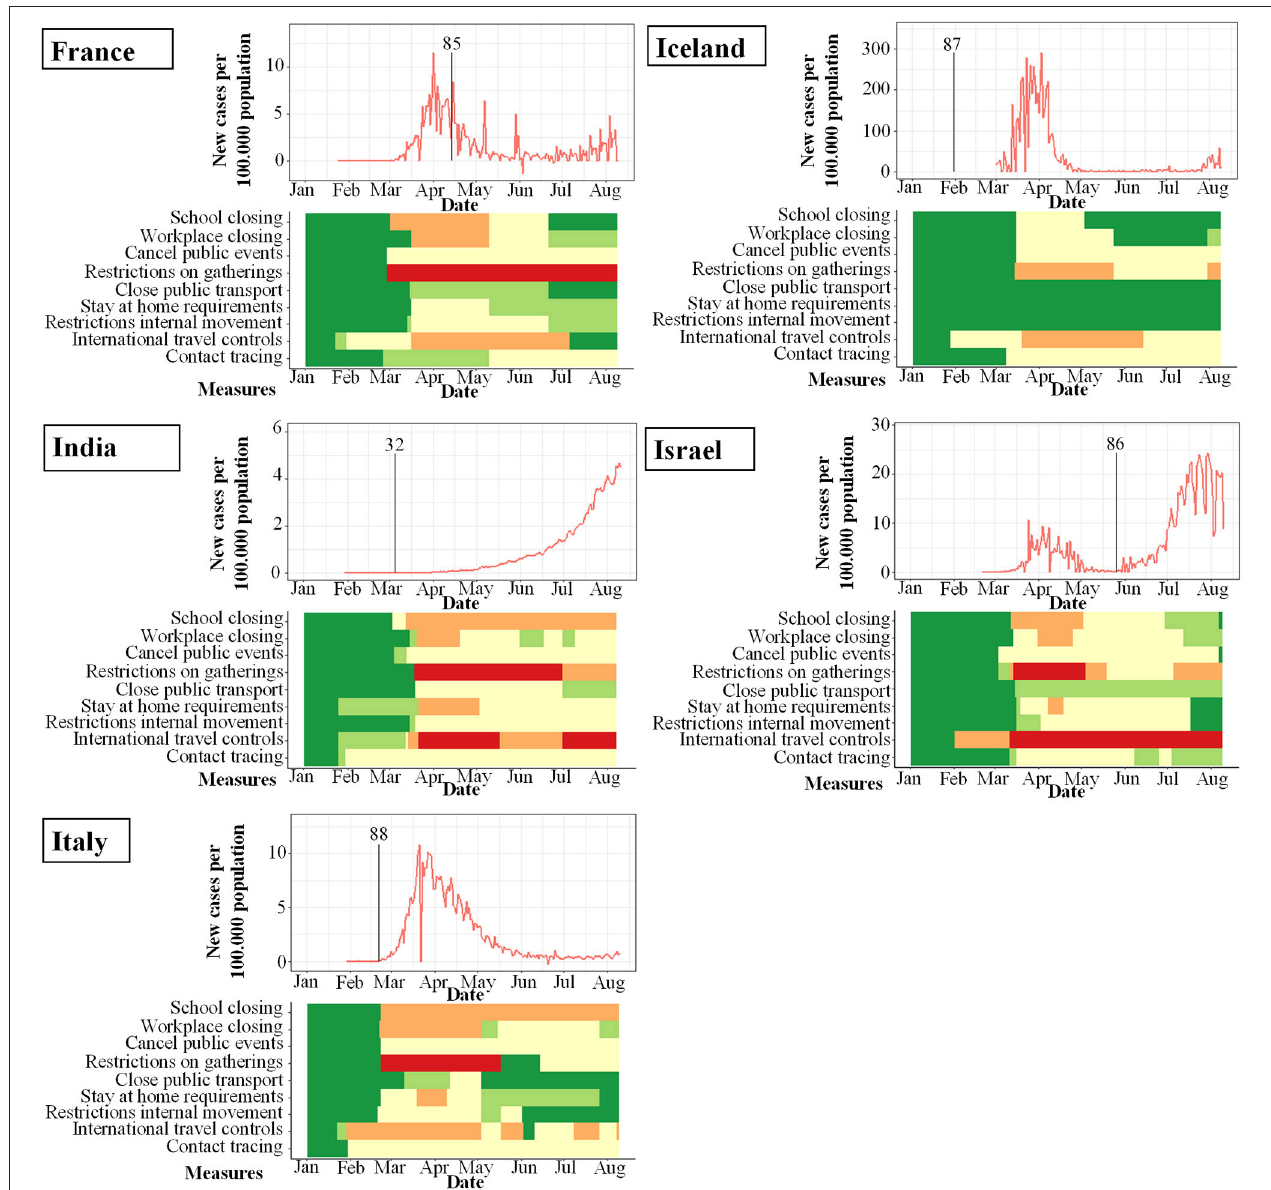
FIGURE 6 | PCR-prevalence studies and their start (indicated by vertical bar) in proportion to incidence of new infections with SARS-CoV-2 per 100.000 per day (y-axis) and changes over time (x-axis). Local response reactions to reduce spread of SARS-CoV-2 are shown below the x-axis in colored bars. Green bars mean no restrictions, red fullrestrictions, e.g., shut down of transport, no gatherings. Dataset of the figure is available in the Supplementary Material